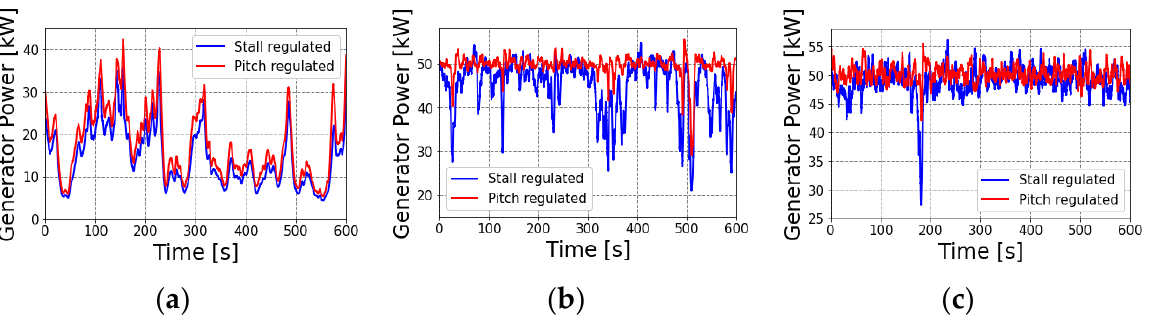
Figure 15. Generator power for a ( a ) 7 m/s average wind speed simulation, ( b ) a 12 m/s average wind speed simulation, and ( c ) a 16 m/s average wind speed simulation.